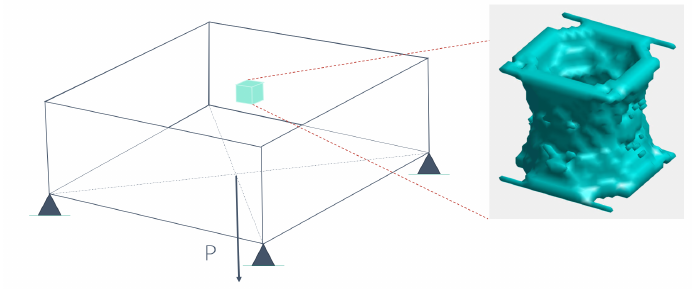
Figure 3. Optimized periodic unit cell for the cantilever beam test example macro